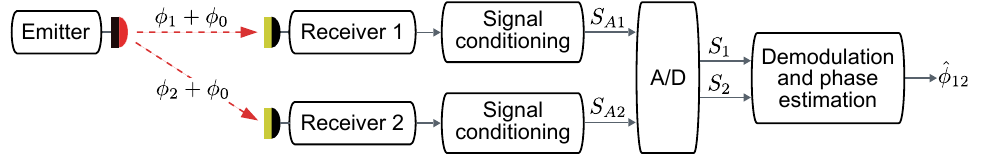
Figure 1. General structure of the differential phase